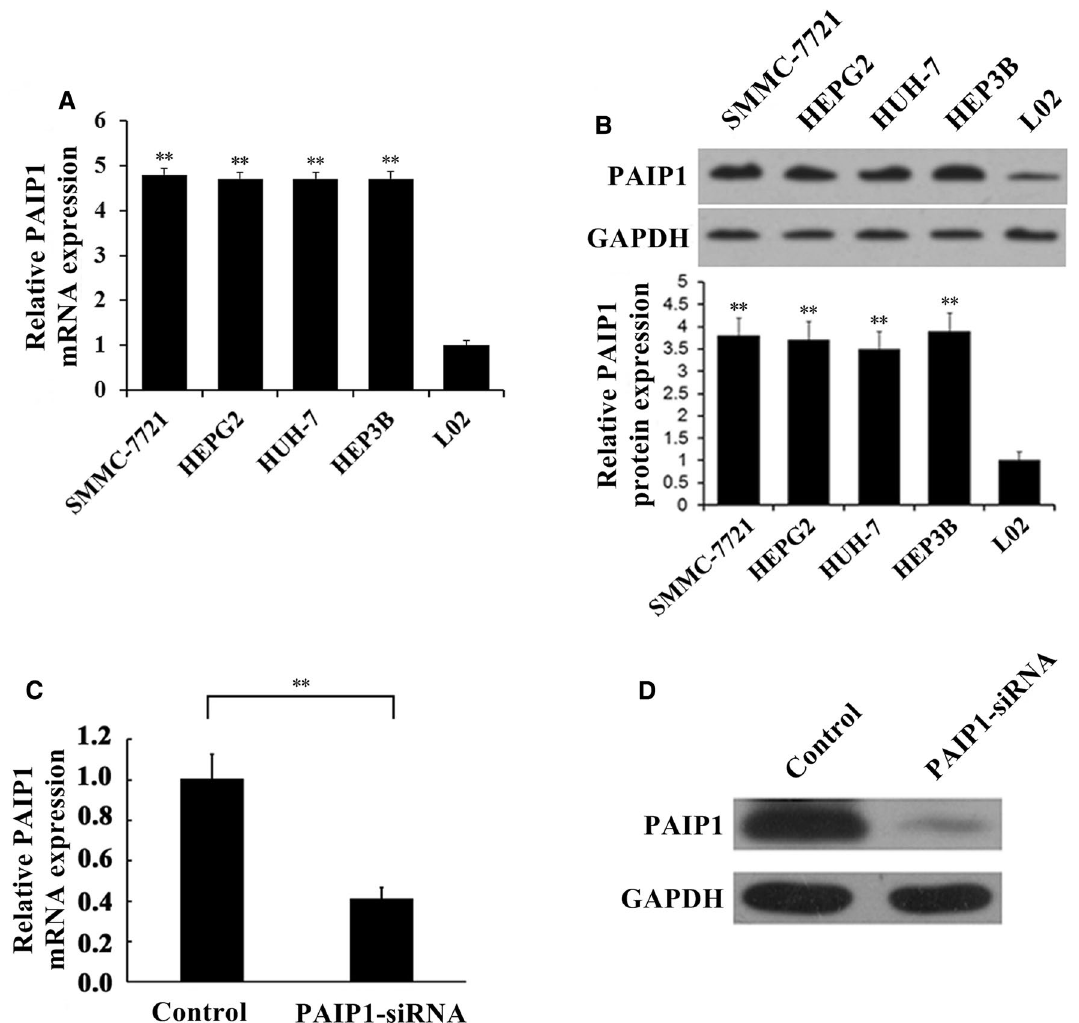
Fig.1 PAIP1 Upregulation in HCC Cell Lines and PAIP1 Knockdown by siRNA. A Real-time polymerase chain reaction (RT-PCR) and B West- ern blotting were used to determine PAIP1 expression in the four HCC cell lines relative to that of the normal hepatocyte cell line L02. C RT-PCR and D Western blotting validated siRNA-mediated PAIP1 knockdown in the SMMC-7721 cell line. The HEPG2 cell line displayed simi- lar siRNA-mediated PAIP1 knockdown (data not shown). GAPDH served as the loading control in all experiments. Results are displayed as means and standard deviations (SDs) from three independent experiments. ** P <